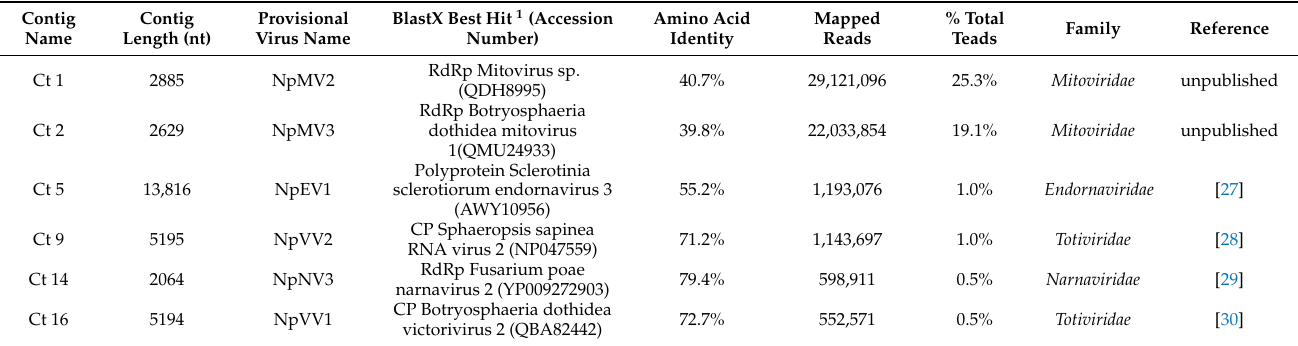
Table 2. Best BLASTX matches of contigs.